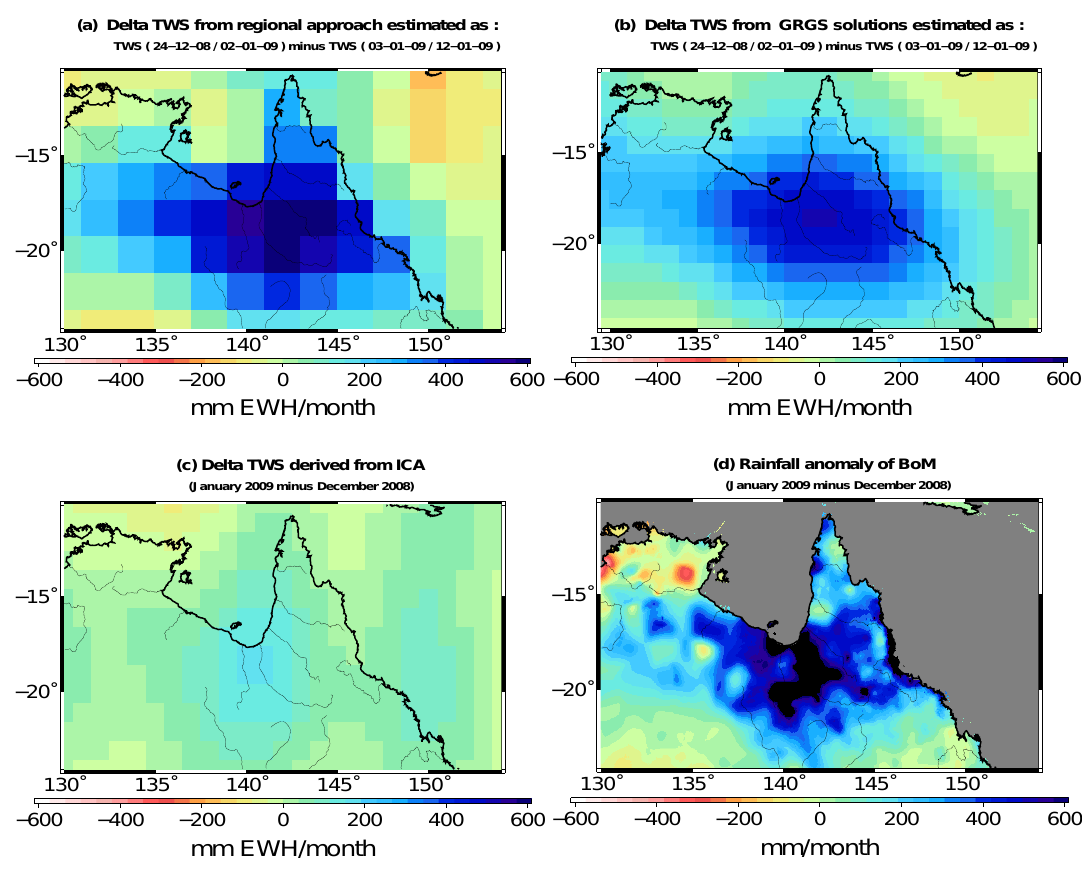
Fig. 13. 1 TWS time series map derived from regional solutions (a) , from GRGS RL02 (b) , from ICA-filtered solutions (c) and rainfall anomalies for January 2009 (d) . We notice in January solutions the strong amplitudes in the Gulf of Carpentaria due to the floods caused by cyclone Charlotte (9 January–12 January